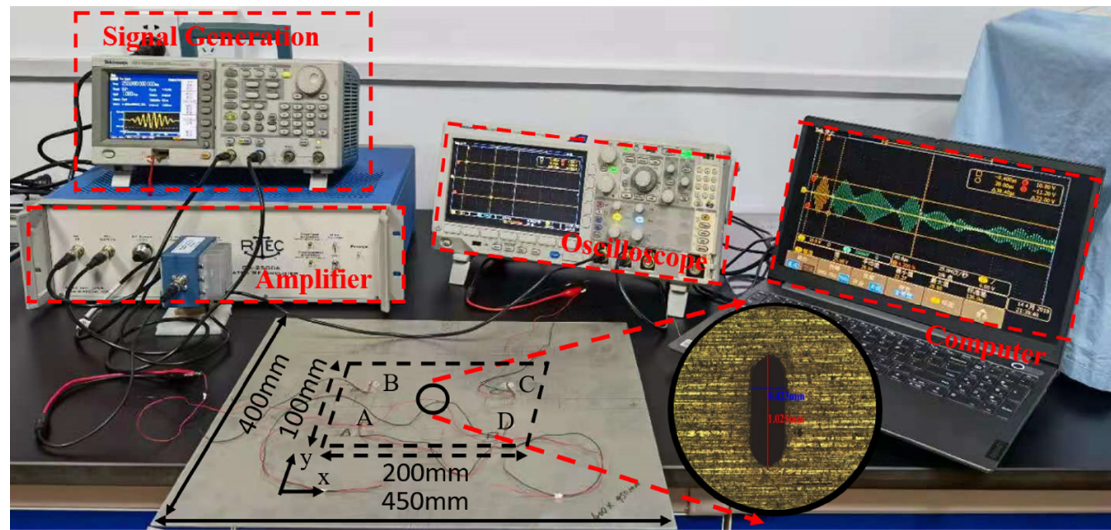
Figure 2. Schematic of the experimental testing system.